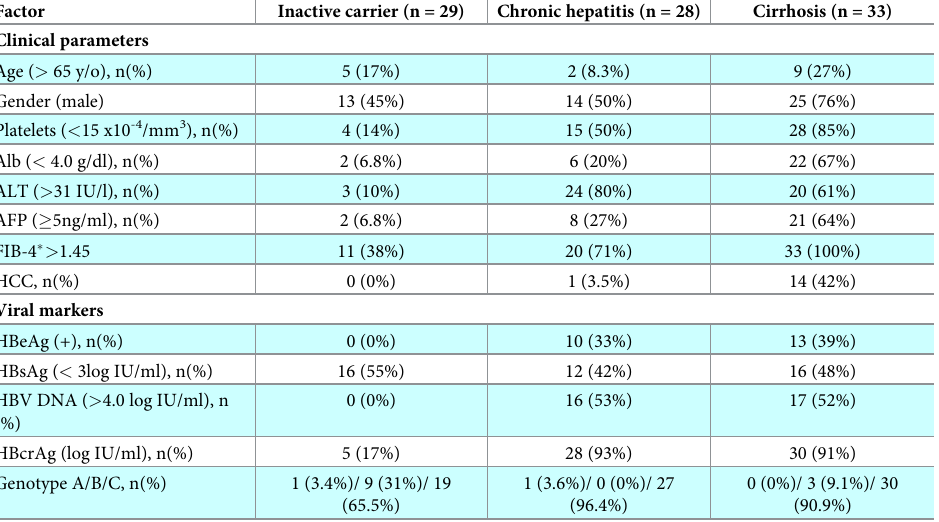
Table 1. Background of the patients. Factor Inactive carrier (n = 29) Chronic hepatitis (n = 28) Cirrhosis (n = 33) Clinical parameters Age ( > 65 y/o), n(%) 5 (17%) 2 (8.3%) 9 (27%) Gender (male) 13 (45%) 14 (50%) 25 (76%) Platelets ( < 15 x10 -4 /mm 3 ), n(%) 4 (14%) 15 (50%) 28 (85%) Alb ( < 4.0 g/dl), n(%) 2 (6.8%) 6 (20%) 22 (67%) ALT ( > 31 IU/l), n(%) 3 (10%) 24 (80%) 20 (61%) AFP ( � 5ng/ml), n(%) 2 (6.8%) 8 (27%) 21 (64%) FIB-4 � > 1.45 11 (38%) 20 (71%) 33 (100%) HCC, n(%) 0 (0%) 1 (3.5%) 14 (42%) Viral markers HBeAg (+), n(%) 0 (0%) 10 (33%) 13 (39%) HBsAg ( < 3log IU/ml), n(%) 16 (55%) 12 (42%) 16 (48%) HBV DNA ( > 4.0 log IU/ml), n 0 (0%) 16 (53%) 17 (52%) (%) HBcrAg (log IU/ml), n(%) 5 (17%) 28 (93%) 30 (91%) Genotype A/B/C, n(%) 1 (3.4%)/ 9 (31%)/ 19 1 (3.6%)/ 0 (0%)/ 27 0 (0%)/ 3 (9.1%)/ 30 (65.5%) (96.4%) (90.9%) Alb, Albumin; ALT, alamine amino transferase; AFP, alfa-fetoprotein; FIB-4, Fibrosis-4; HCC, hepatocellular carcinoma; HBeAg, hepatitis B e antigen; HBsAg, hepatitis B surface antigen; HBV DNA, hepatitis B virus DNA; HBcrAg, hepatitis B core-related